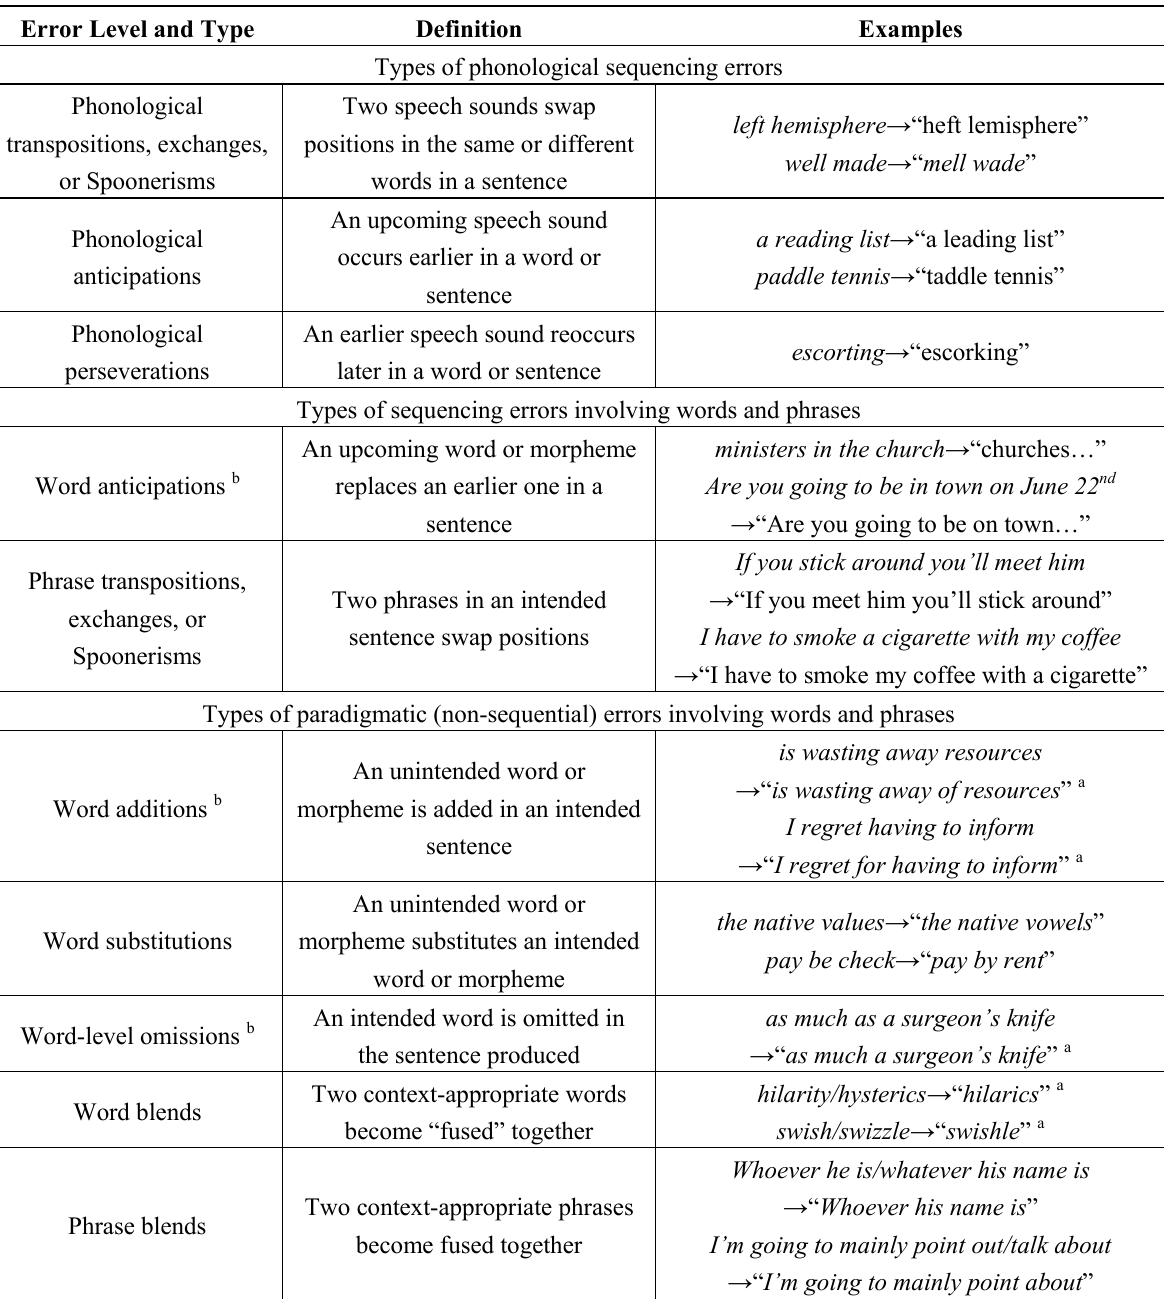
Table 1. Classical types of everyday speech errors and sequential class regularities: Definitions and